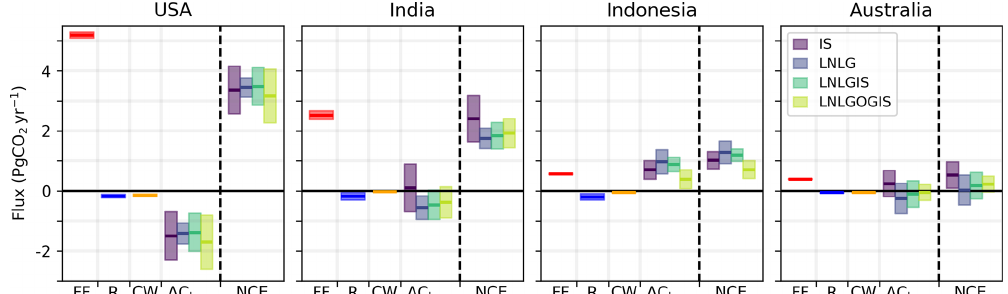
Figure 13. CO 2 budget for the USA, India, Indonesia and Australia averaged over 2015–2020. Bars show the median ± 1 standard deviation of FF, F rivers export ( R ), F crop trade + F wood trade (CW), (cid:49)C loss and NCE (note that these quantities are related through Eq. 2).